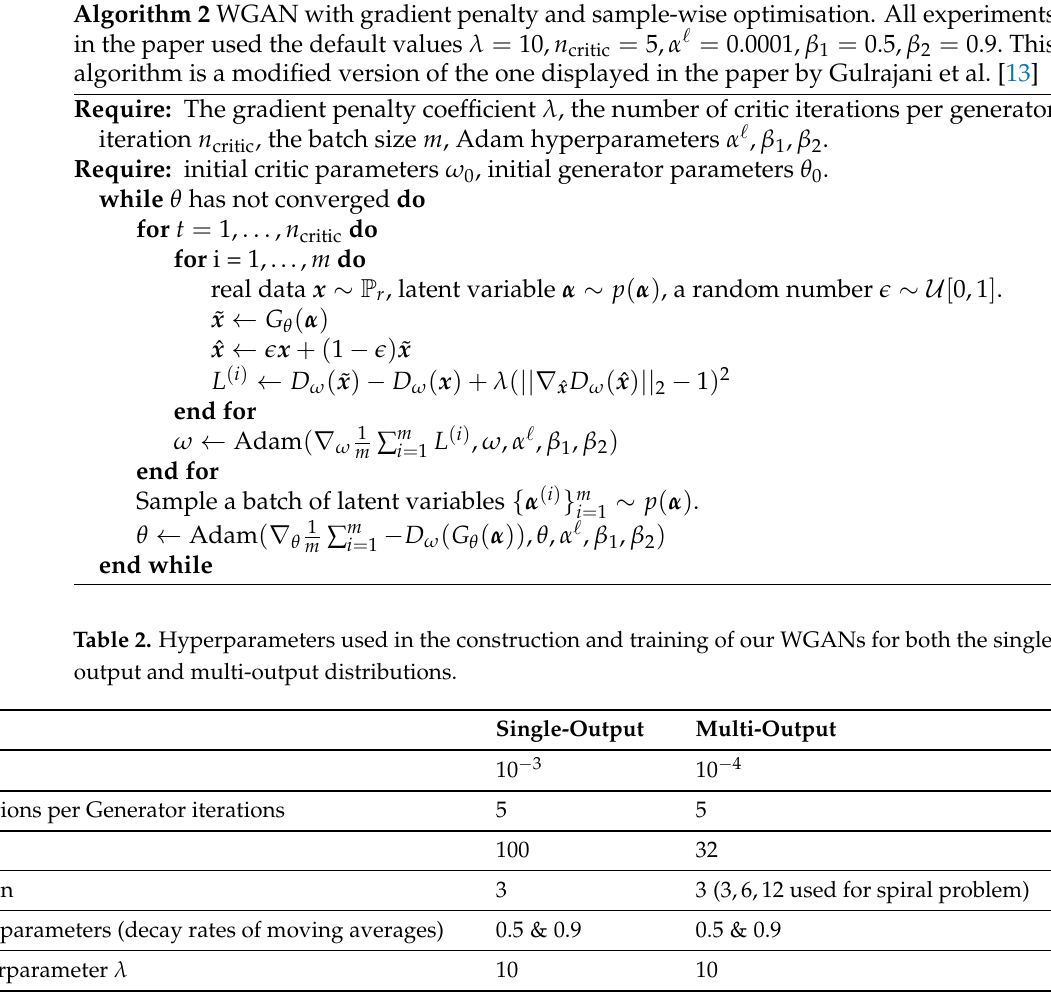
Algorithm 2 WGAN with gradient penalty and sample-wise optimisation. All experiments